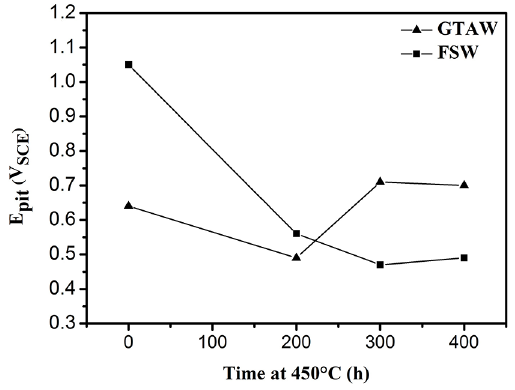
Figure 12. Polarization curves of un-aged FSW and GTAW